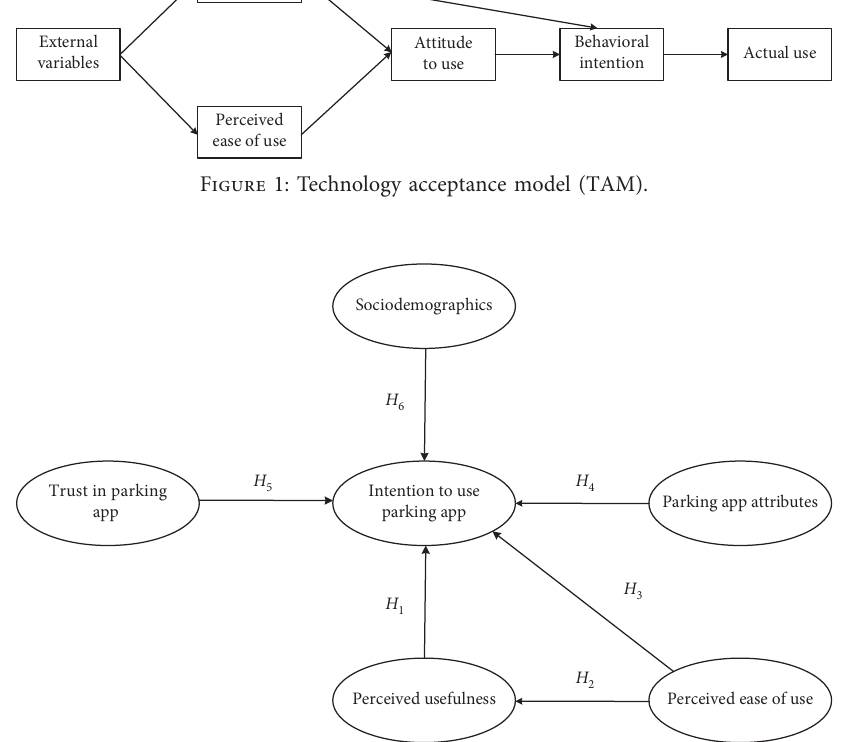
Figure 2: Structural model of drivers’ intention to accept parking